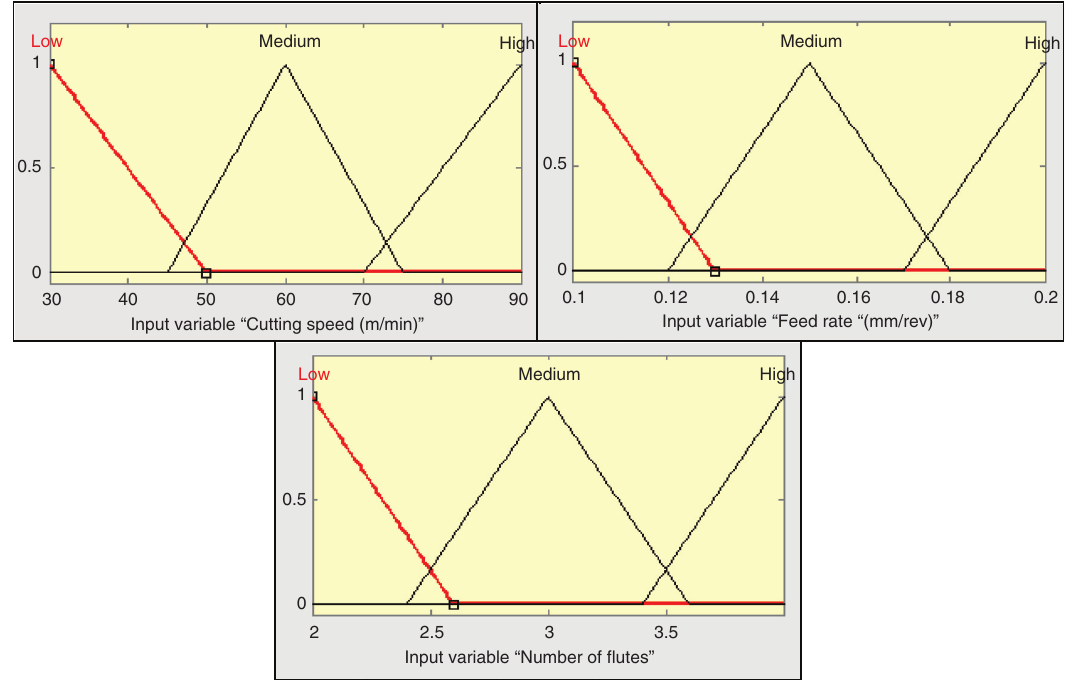
Figure 5 The membership functions and the number range of input